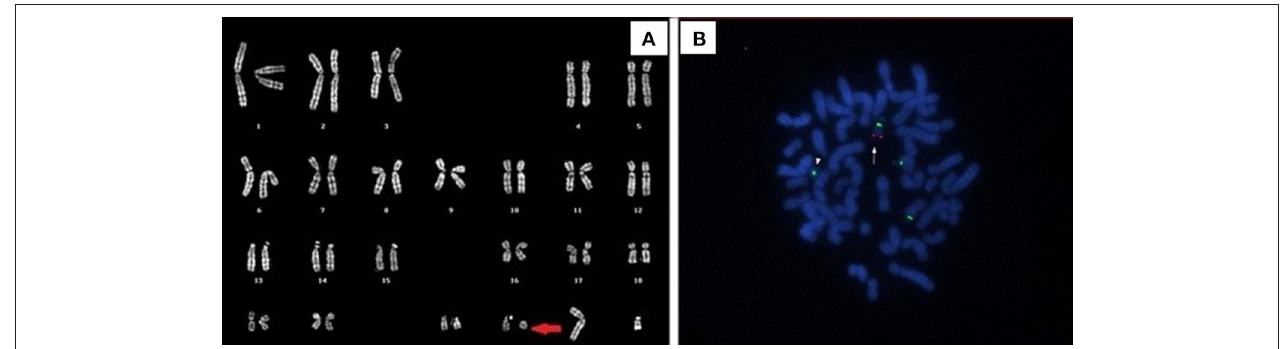
FIGURE 6 | (A) Q-banded karyotype showing ring chromosome 22. (B) FISH analysis with 14/22 centromeric probe and specific SHANK3 probe (green and red signals, respectively). The arrow indicates the normal chromosome 22, the arrowhead shows the absence of SHANK3 signal on the ring chromosome